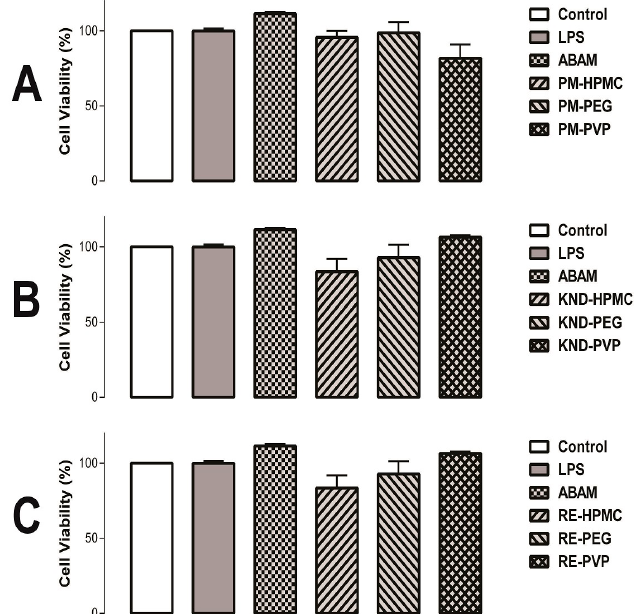
Figure 7. Effect of ABAM (alone and dispersed within the hydrophilic polymers) on cell viability. ( A ) Cell viability of the physical mixtures and ABAM compared to the control group; ( B ) Cell viability of ABAM and its SDs prepared by KND compared to that of the control group; ( C ) Cell viability of ABAM and its SDs prepared by RE compared to that of the control group. p > 0.05 when compared with the control group by one-way ANOVA followed by Newman–Keuls test.